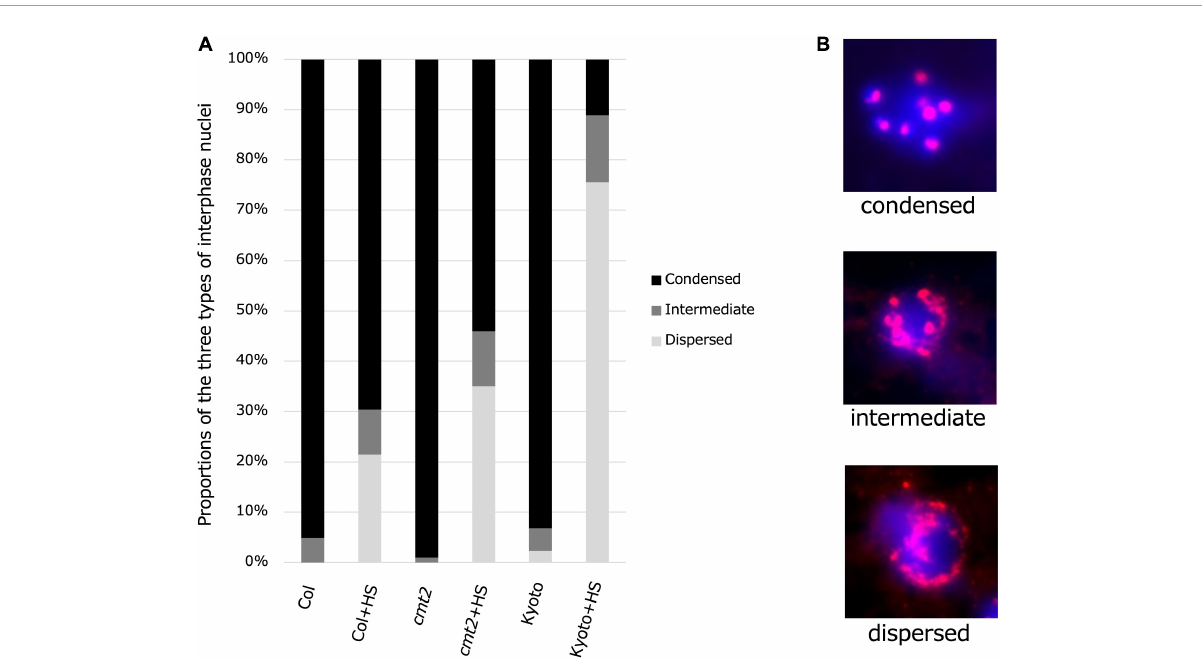
FIGURE7 Condensatoin in interphase nuclei. (A) Proportions of three types of interphase nuclei observed in Col-0, cmt2 , and Kyoto subjected to control or 24 h of high-temperature stress (HS24). (B) Representative images of types of interphase